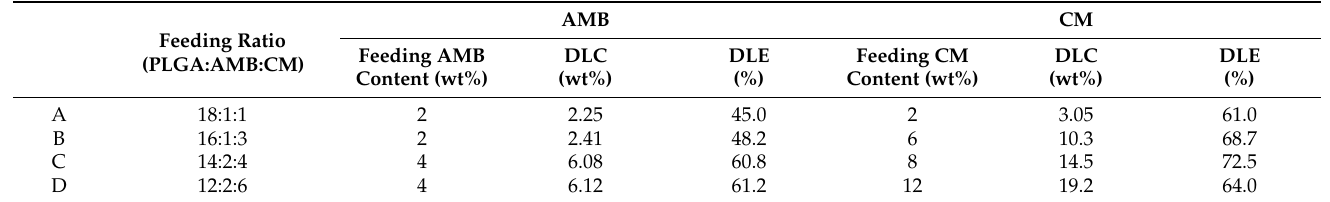
Figure 1. Morphology of the porous particles observed by SEM: ( A ) PLGA MPs; ( B ) AMB/CM-PLGA MPs; ( C ) cross-section of AMB/CM-PLGA MPs. Particle size distributions of the porous particles: ( D ) PLGA MPs and AMB/CM-PLGA MPs. Table 1. Investigation of the drug loading content (DLC) and drug loading efficiency (DLE) of AMB/CM-PLGA